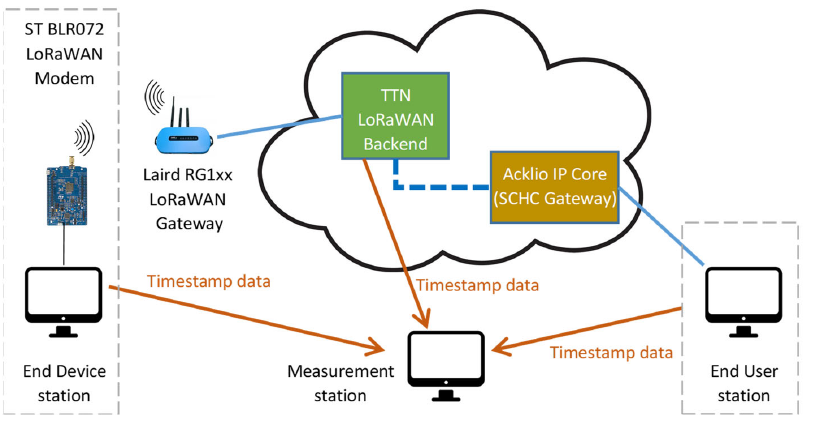
Figure 8. Setup of the reference real ‐ world use case.